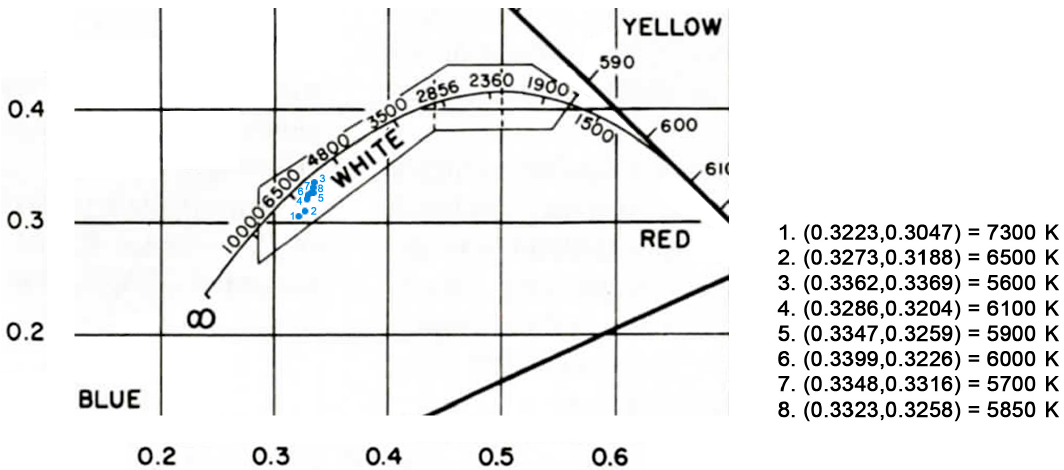
Figure 7. From the CIE 1931 chromaticity diagram of the Wyszecki and Stiles book (Figure 1(3.10)) [44]